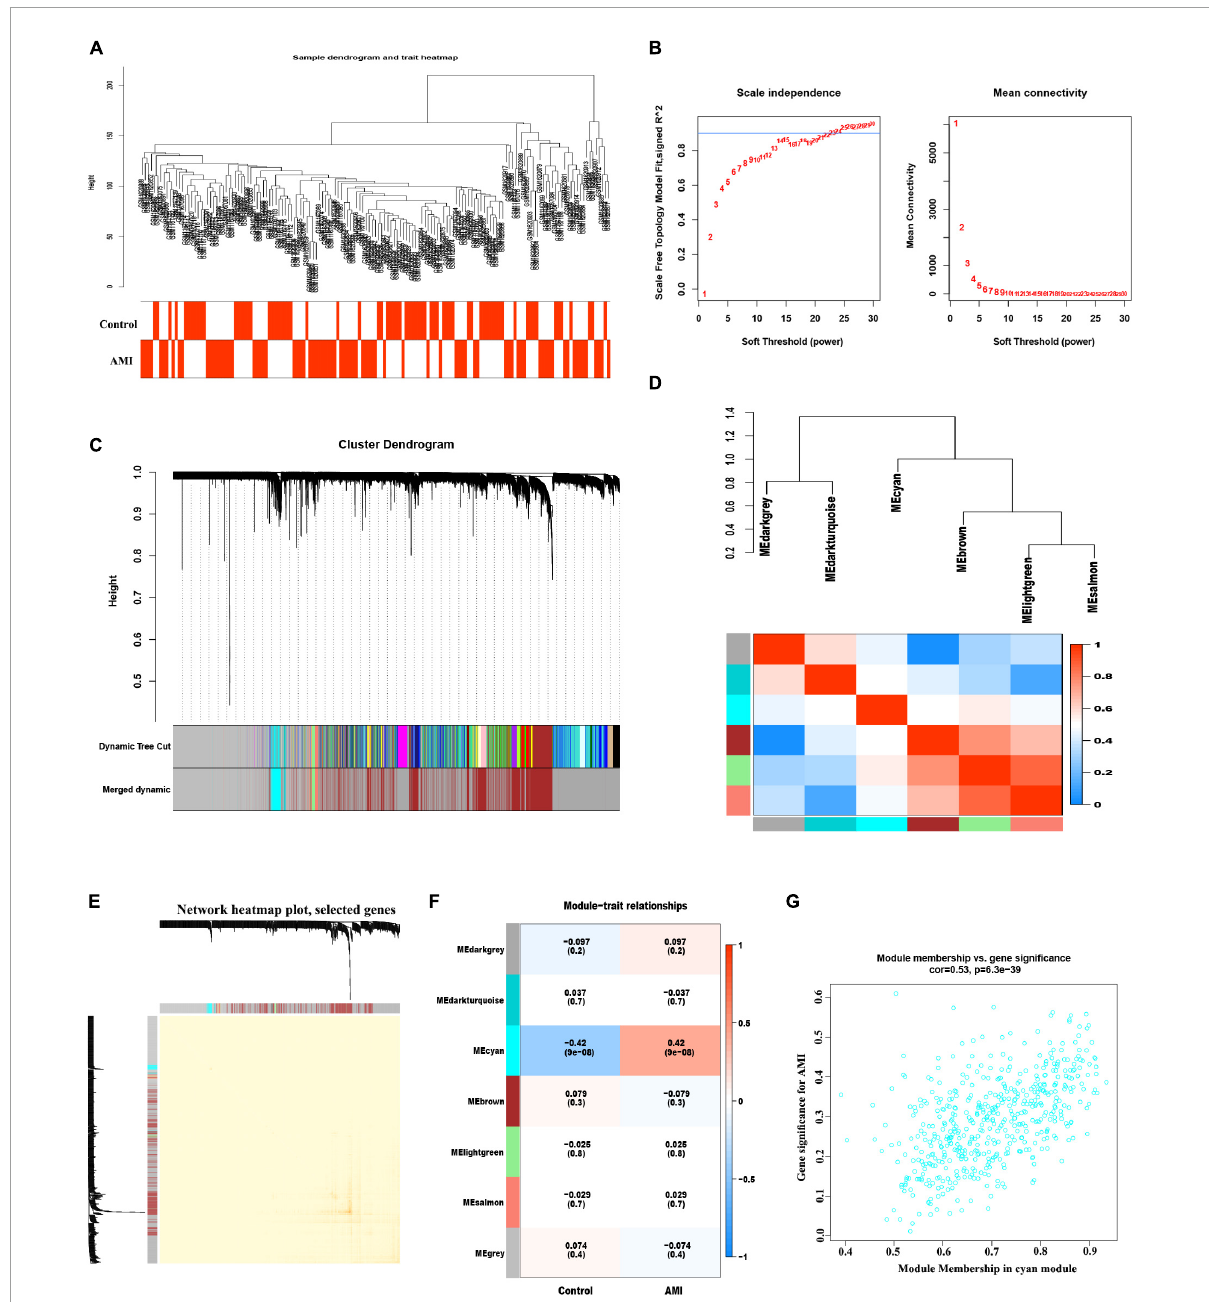
FIGURE3 Weight correlation network analysis. (A) Sample clustering dendrogram with tree leaves corresponding to individual samples. (B) Analysis of the scale-free fit index (R 2 ) and the mean connectivity for various soft-thresholding powers. (C) The original and combined modules under the clustering tree with cut-off values height of 0.25. (D) Collinear heat map of module feature genes. Red color indicates a high correlation, blue color indicates the opposite results. (E) Clustering dendrogram of module feature genes. (F) Heat map of module–trait correlations. Red represents positive correlations and blue represents negative correlations. (G) MM vs. GG scatter plot of AMI for cyan module.